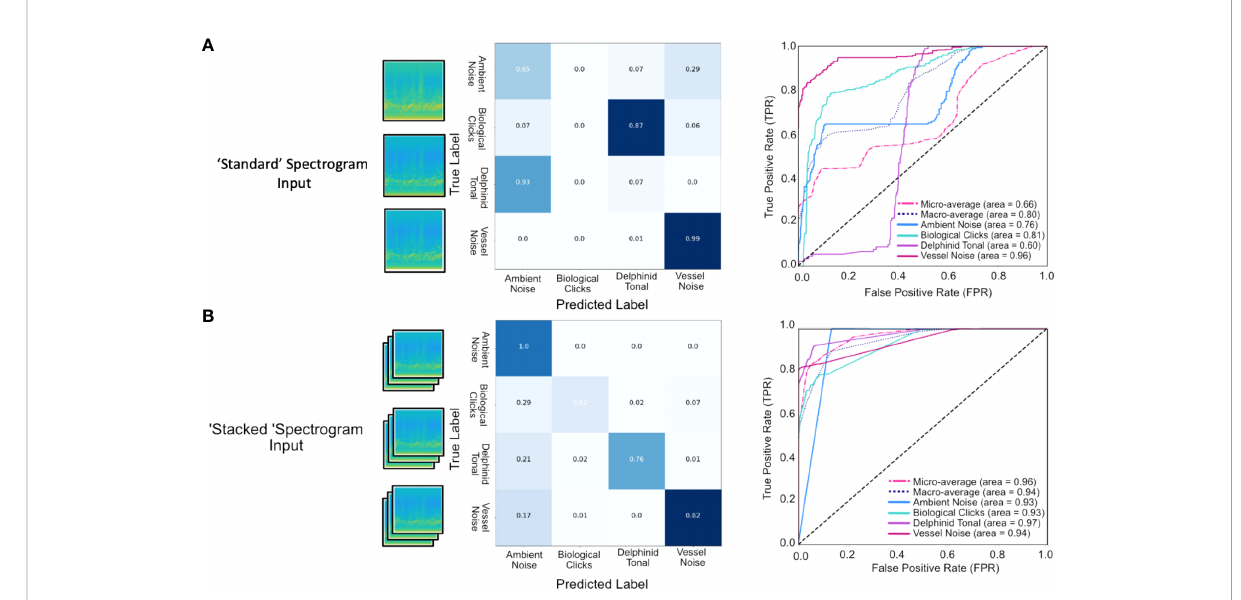
FIGURE 8 Performance of the CNN on the test set (10% of the initial training data) for each of the four sound classes as illustrated using Confusion Matrices and ROC curves for (A) Standard spectrogram input and (B) Stacked spectrogram input. The stacked input outperformed the standard spectrogram input reporting a macro average of 0.94, compared to 0.80. Performance was high for all sound classes with the highest accuracy for ambient noise and vessel noise which are the classes comprising the greatest proportion of the training set based on true vs predicted labels for the stacked input. Although making up the smallest component of the training set, biological click detection remained high, with an AUC of 0.93, with false negatives in this class attributed to single click